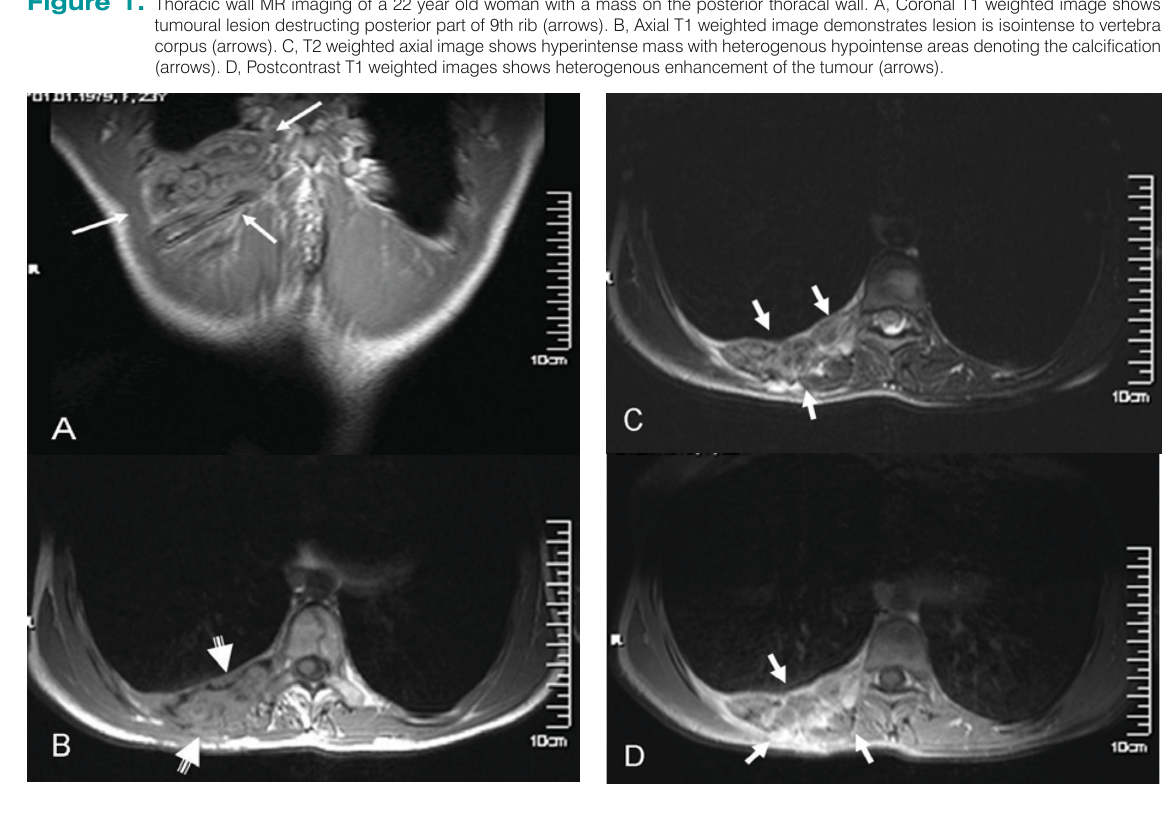
Figure 2. Axial thoracic vertebra CT image shows expansile hyperdense tumoural mass at the right 9 th rib corresponding to osteosarcoma (arrows).